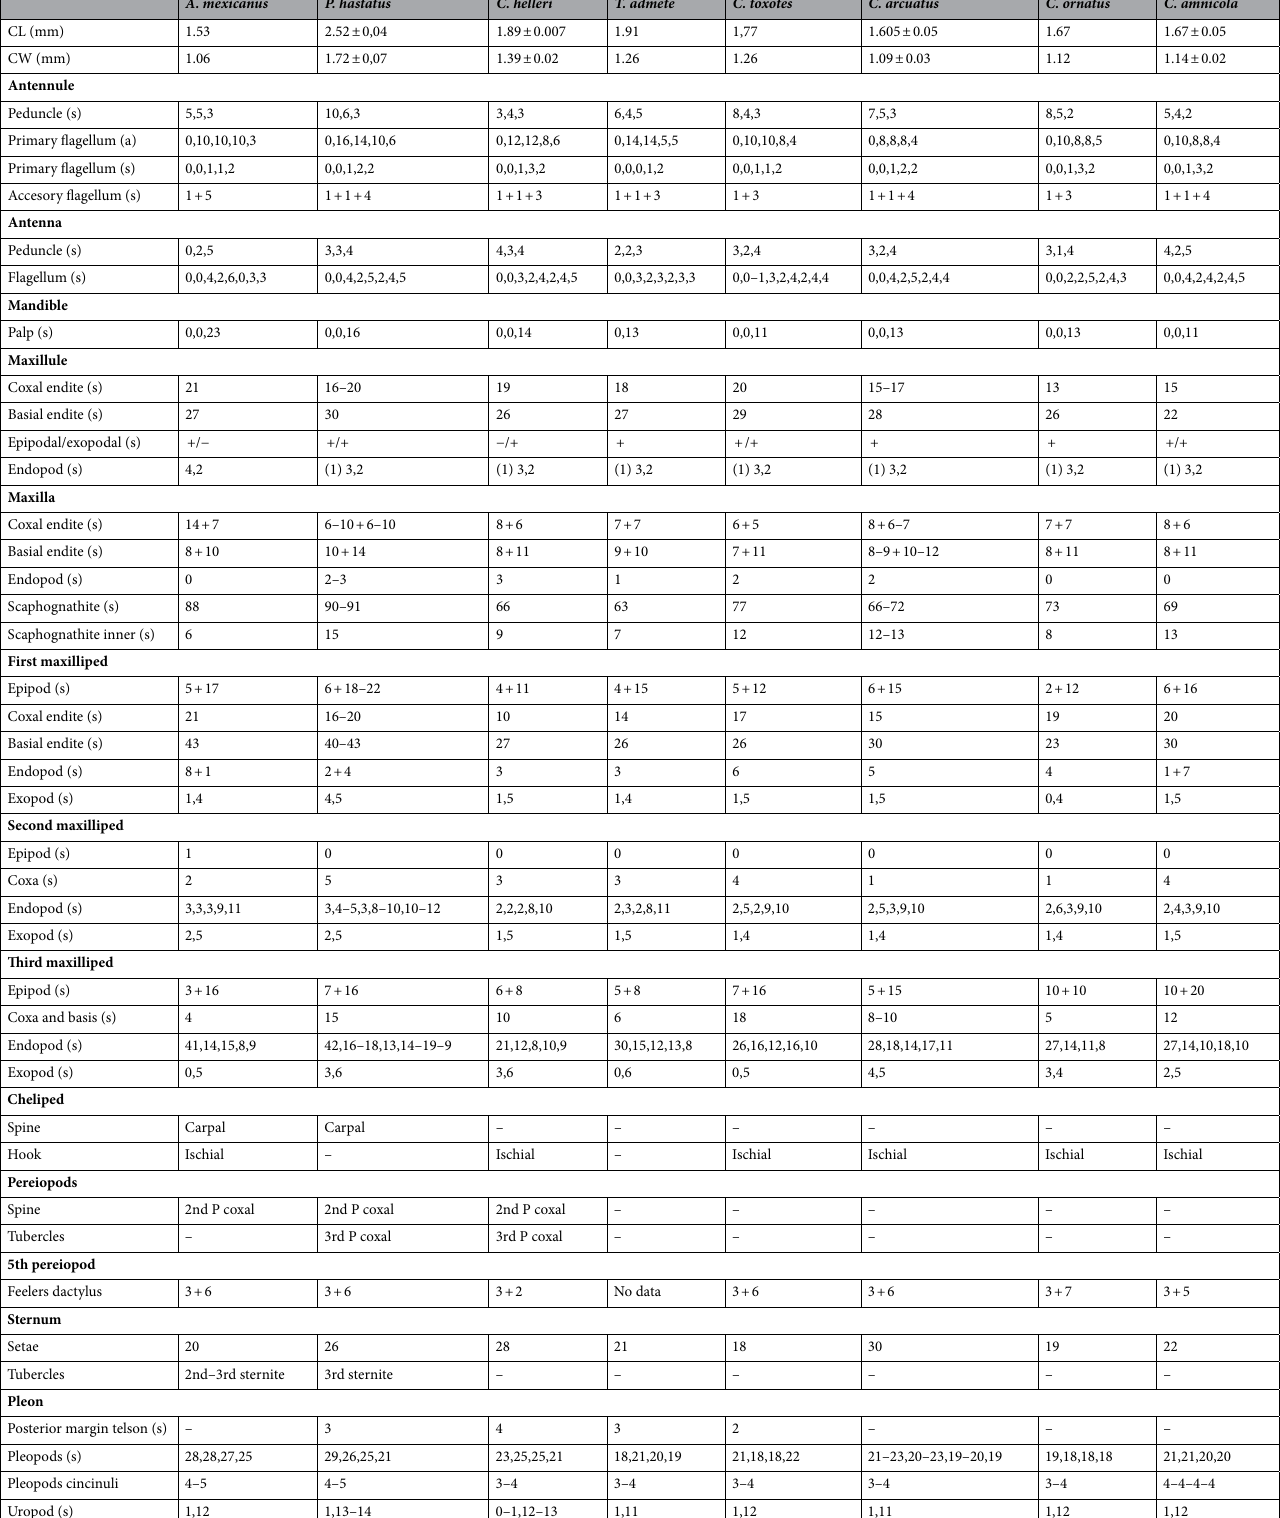
Table 2. Meristic and morphological characters of the megalopa stage of 8 species of the family Portunidae: Arenaeus mexicanus, Portunus (Portunus) hastatus, Charybdys (Charybdys) hellerii, Thalamita admete, Callinectes toxotes, Callinectes arcuatus, Callinectes ornatus, and Callinectes amnicola . a aesthetacs, s setation, P pereiopod, + present, –